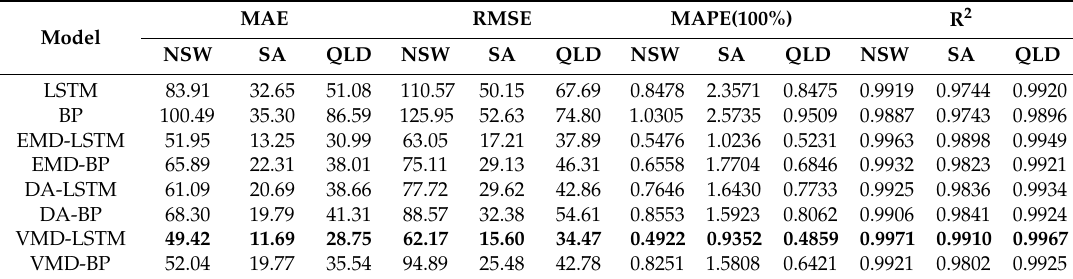
Comparison of the prediction performance of models using di ff erent data preprocessing